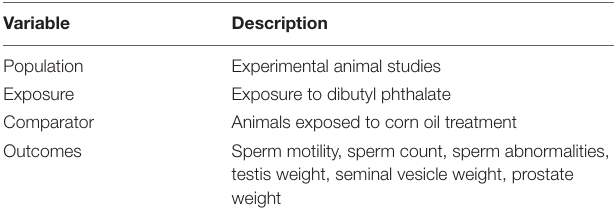
TABLE 1 | PECO statement (population, exposure, comparator and